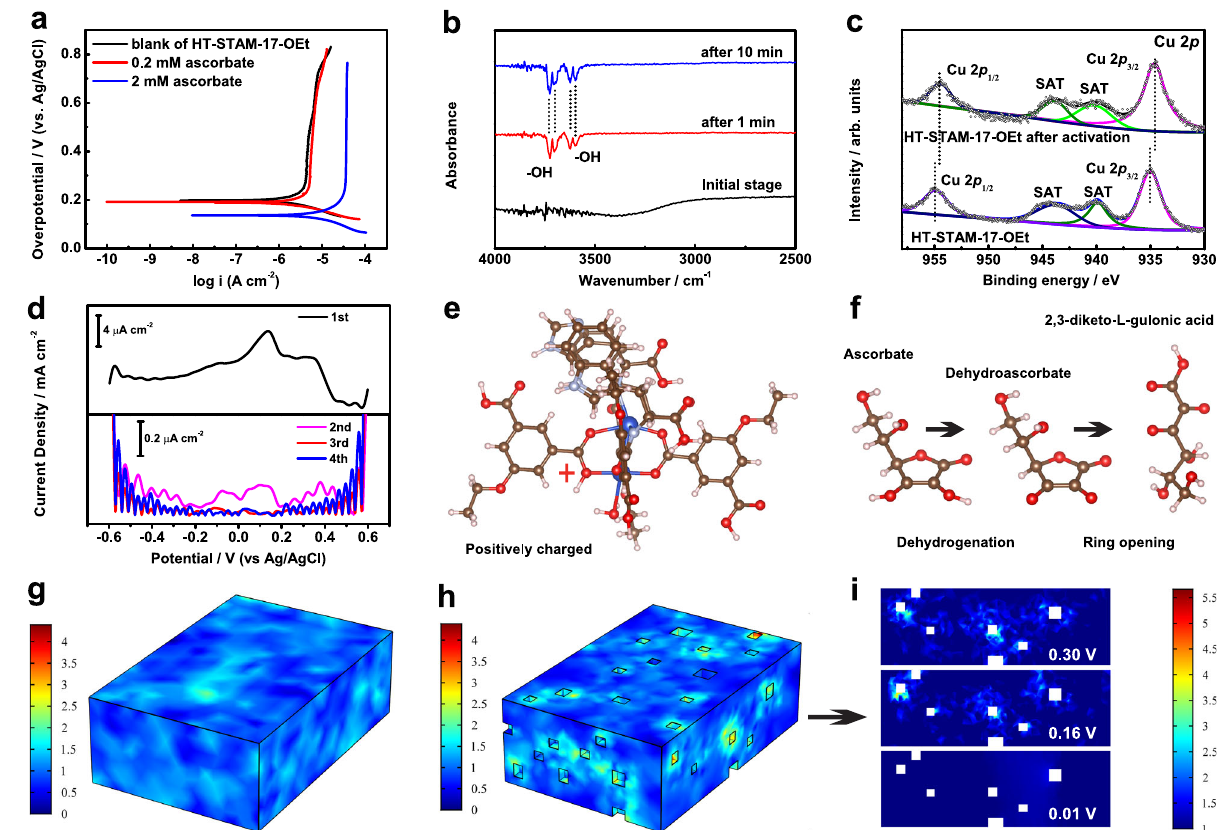
Fig. 5 | Electrochemical ascorbate oxidation mechanism of HT-STAM-17-OEt. a PotentiodynamicpolarizationcurvesofHT-STAM-17-OEtin0.1MNaCl(pH=7)in theabsenceandpresenceofascorbate. b InsituEC-IRspectrumofHT-STAM-17-OEt in0.1MNaCl(pH=7)atdifferenttimesat0.5Vvs.Ag/AgCl. c Cu2 p XPSpro fi lesof HT-STAM-17-OEt. d Resolved 1st, 2nd, 3rd, and 4th harmonic components of AC voltammograms for HT-STAM-17-OEt in 0.1M NaCl ( f =9Hz, Δ E =0.080V).